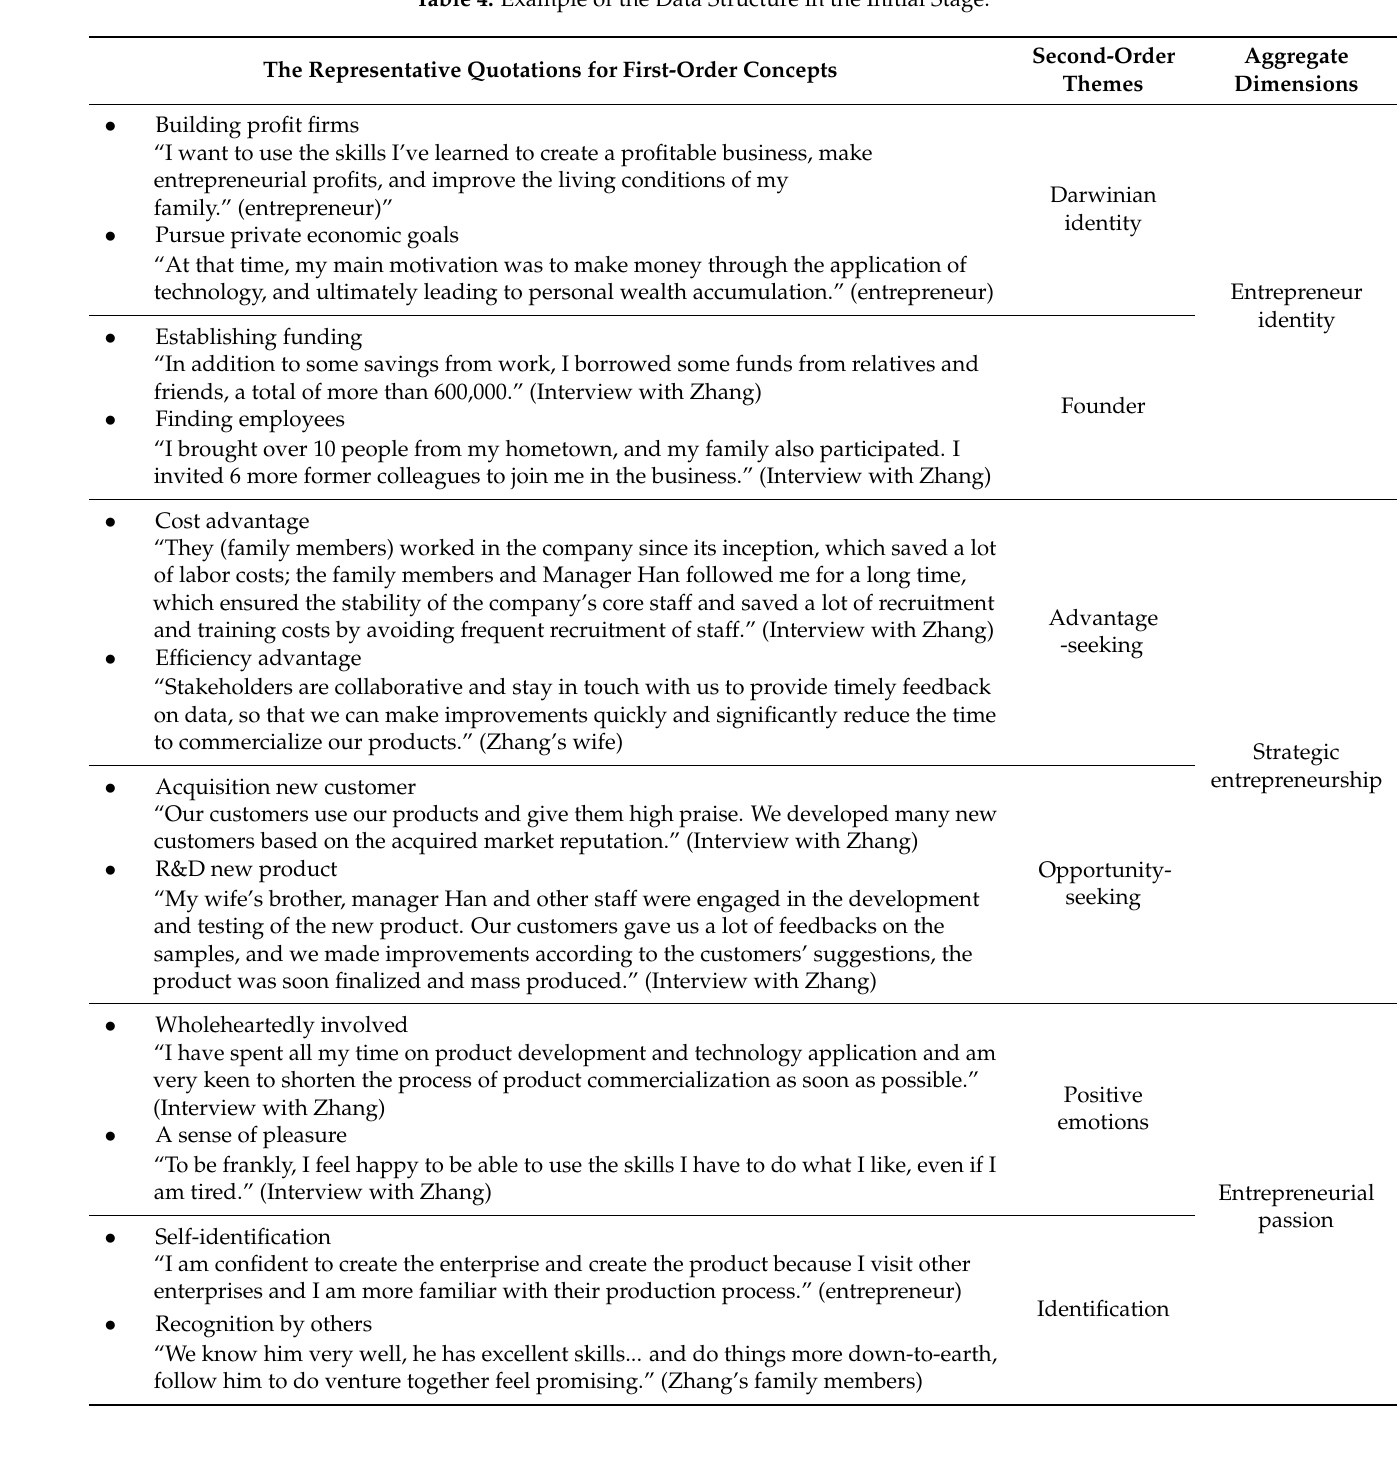
Table 4. Example of the Data Structure in the Initial